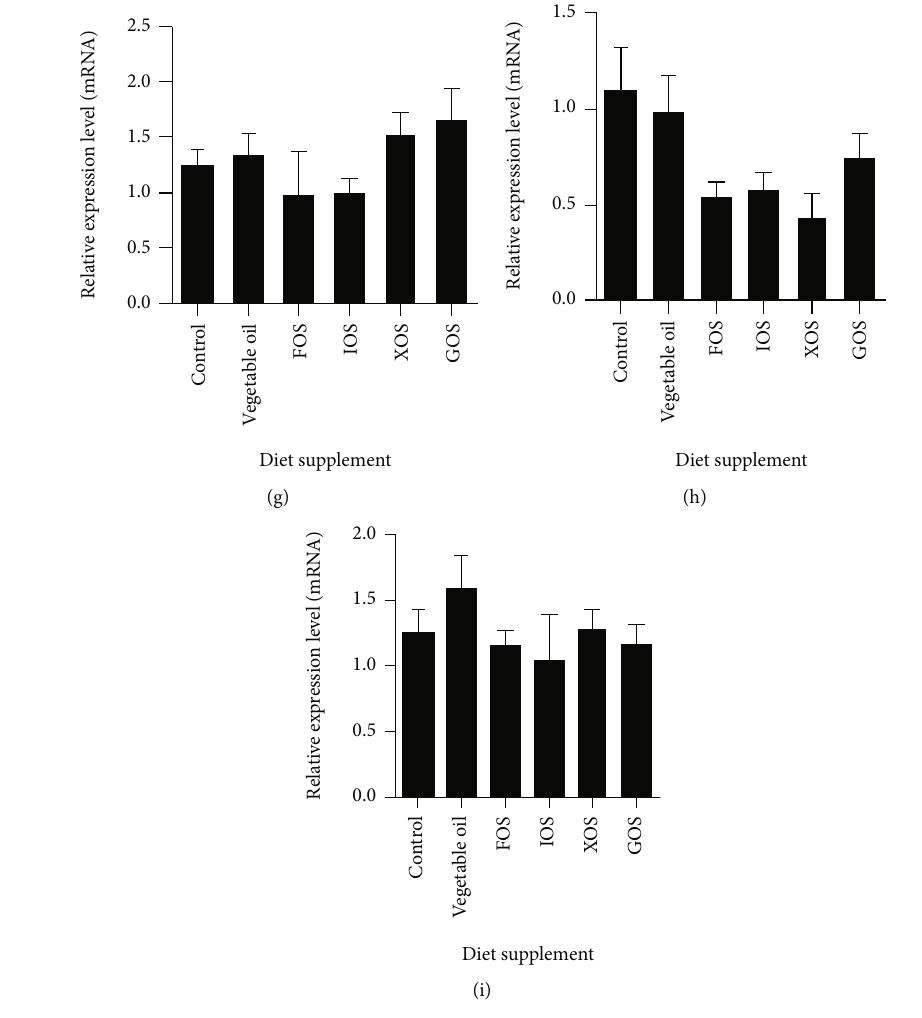
Figure 3: Transcript analysis of fi sh metabolism-related genes. The relative expression levels of glutathione S-transferase (a), glutathione peroxidase (b), glutathione-disul fi de reductase (c), growth hormone receptor II (d), catalase (e), superoxide dismutase (f), fatty acid synthase (g), acetyl-CoA carboxylase β (h), and carnitine palmitoyl transferase 1 (i) were tested using qPCR. ∗ 0 : 01 < p < 0 : 05 ; ∗∗ p < 0 : 01 ; n = 6 − 24